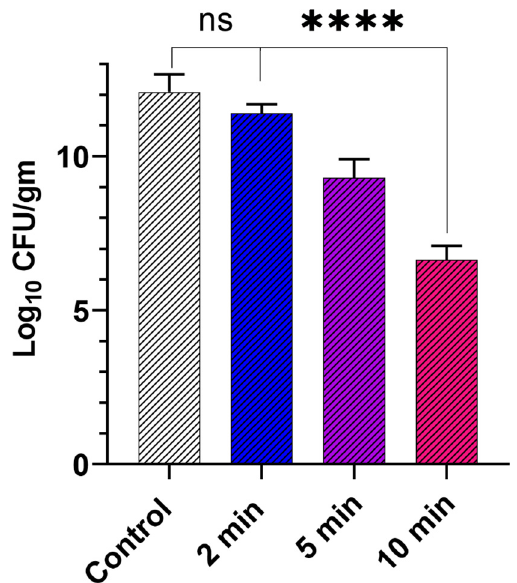
Figure 7. The viability of Xen29 biofilms collected from infected mouse skin wound after treatment with GaPP in LCNP 50 µM activated with blue light at different time intervals using 0.267 W/cm 2 irradiance, compared to the control group incubated with PBS and illuminated with blue light for 10 min. Data presented as mean ± SD ( n = 6, three technical replicates and 2 biological replicates); ns: non-significant, **** p value < 0.0001 (one-way ANOVA test followed by multiple comparison Dunnett’s test).